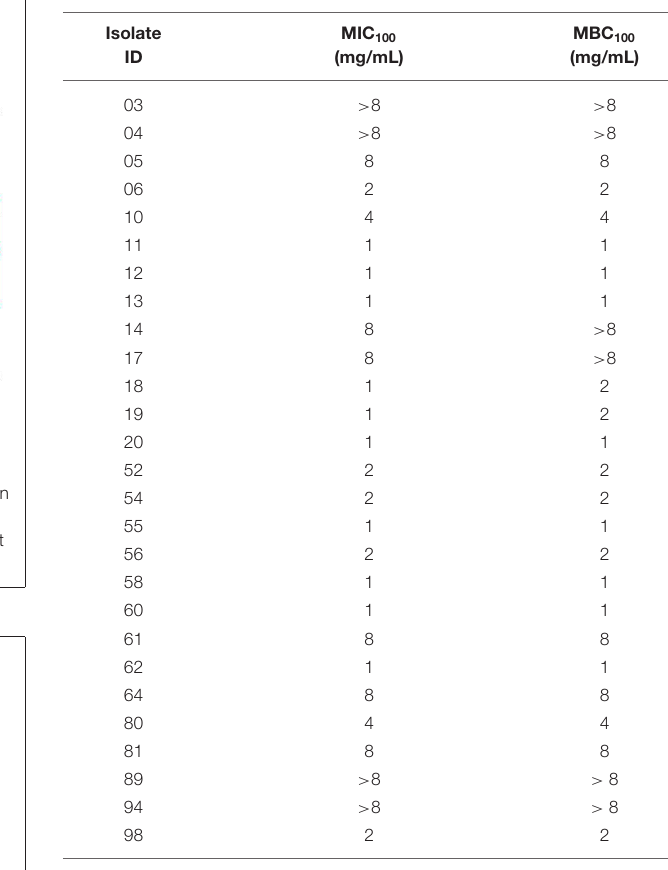
TABLE 1 | Sensitivity of C. pseudotuberculosis clinical isolates obtained from sheep with caseous lymphadenitis to green propolis